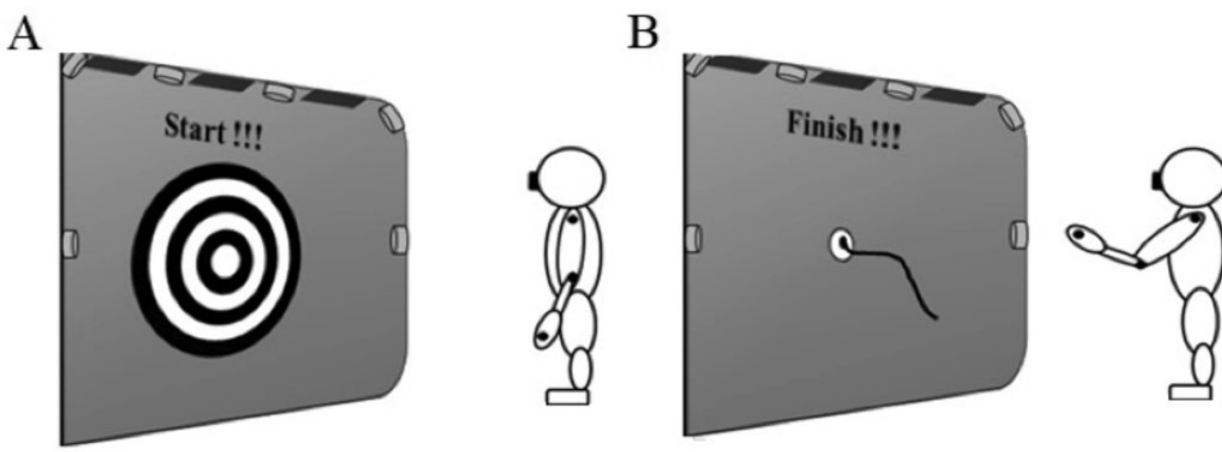
Figure 2. Task knowledge of performance, (A) initial position, (B) final position.